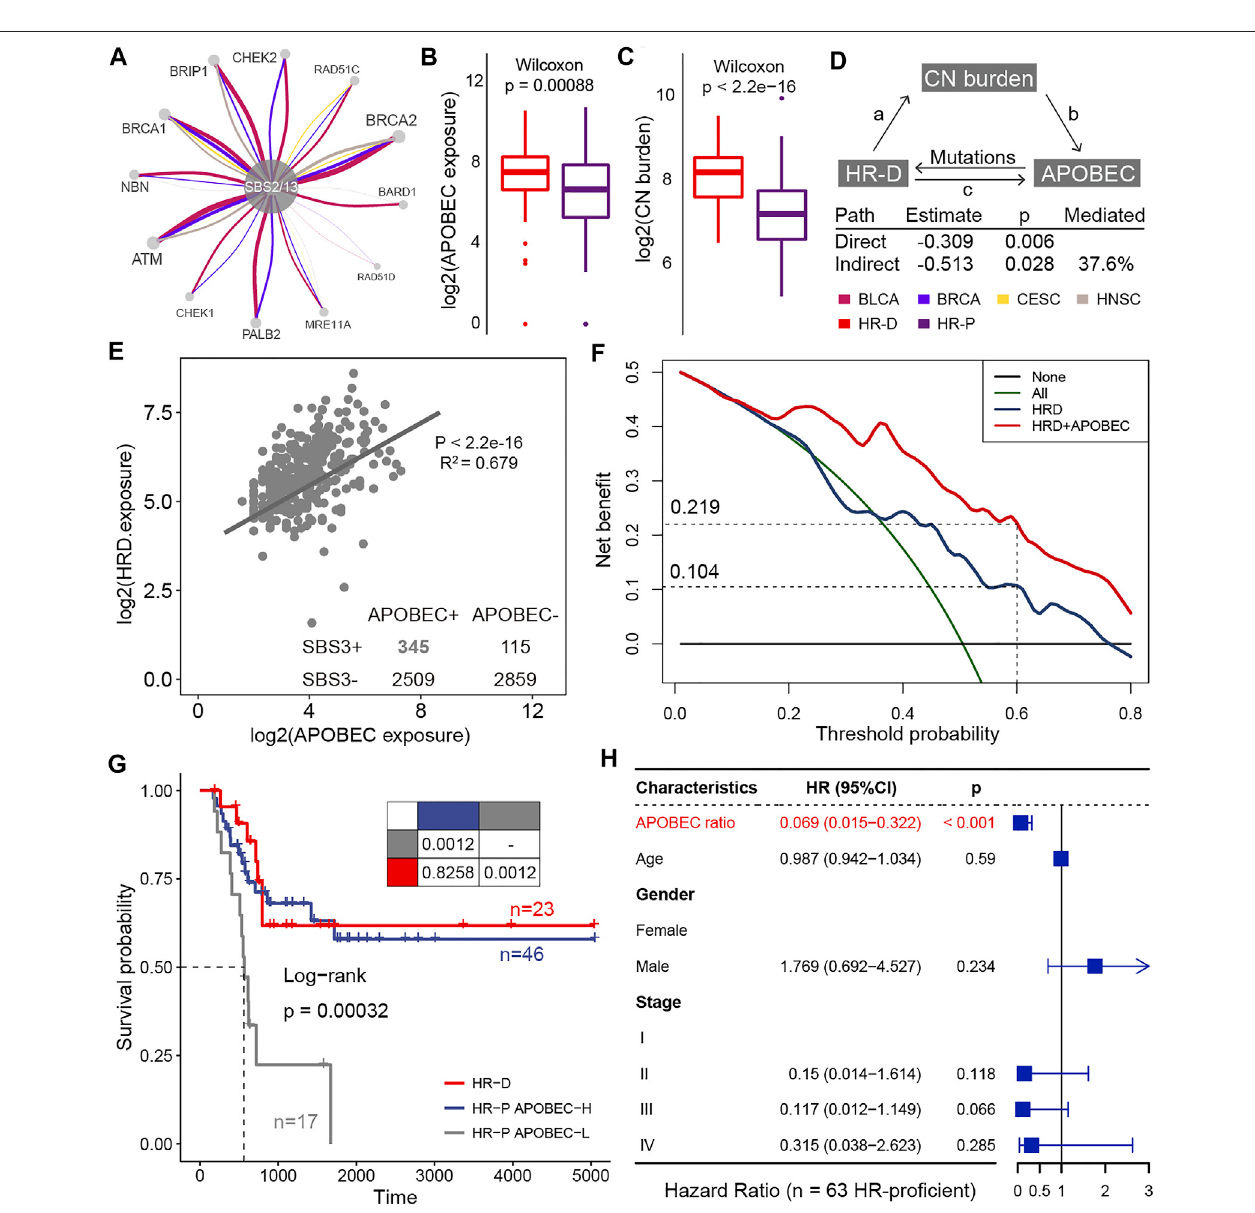
FIGURE 5 | The clinical actionability of APOBEC mutational process. (A) HR-related genes affected by APOBEC mutation processes in BLCA, BRCA, CESC, and HNSC.Thethicknessoftheedgeconnectingtwonodesisproportionaltothenumberofassociationsinallsamples. (B) DifferencesinAPOBECexposurebetweenHRD and HRP groups. (C) Differences in copy number burden between HRD and HRP groups. (D) Mediation analyses examining copy number burden between HRD and APOBEC exposure. (E) A scatter plot shows correlationsbetween the log exposure value of APOBEC mutational signatures (SBS2 plus SBS13, x-axes) and HRD signature (SBS3, y-axes). Each dot represents a sample and the line shows best estimates for the slope estimated by mixed effect model in samples that APOBEC mutational signatures and HRD signature co-occurred. (F) The decision curve of the net bene fi t of the two models (HRD score and the combination of HRD score and APOBEC mutational process contribution) for the 5-years survival rate. (G) Kaplan – Meier curves for homologous recombination de fi cient (HR-D; n (cid:1) 23), homologous recombination pro fi cient but APOBEC activity high (HR-P APOBEC-H; n (cid:1) 46), and homologous recombination pro fi cient but APOBEC activity low (HR-P APOBEC-L; n (cid:1) 17)patientswhotreatedwithplatinum-basedadjuvanttherapy.Pairwisecomparisonsofsurvivalcurvesarepresentedinthetable. (H) Hazardratiosforthevariables in the Cox regression model. The horizontal bars show the 95% CI; the P values are calculated with two-sided likelihood-ratio tests.